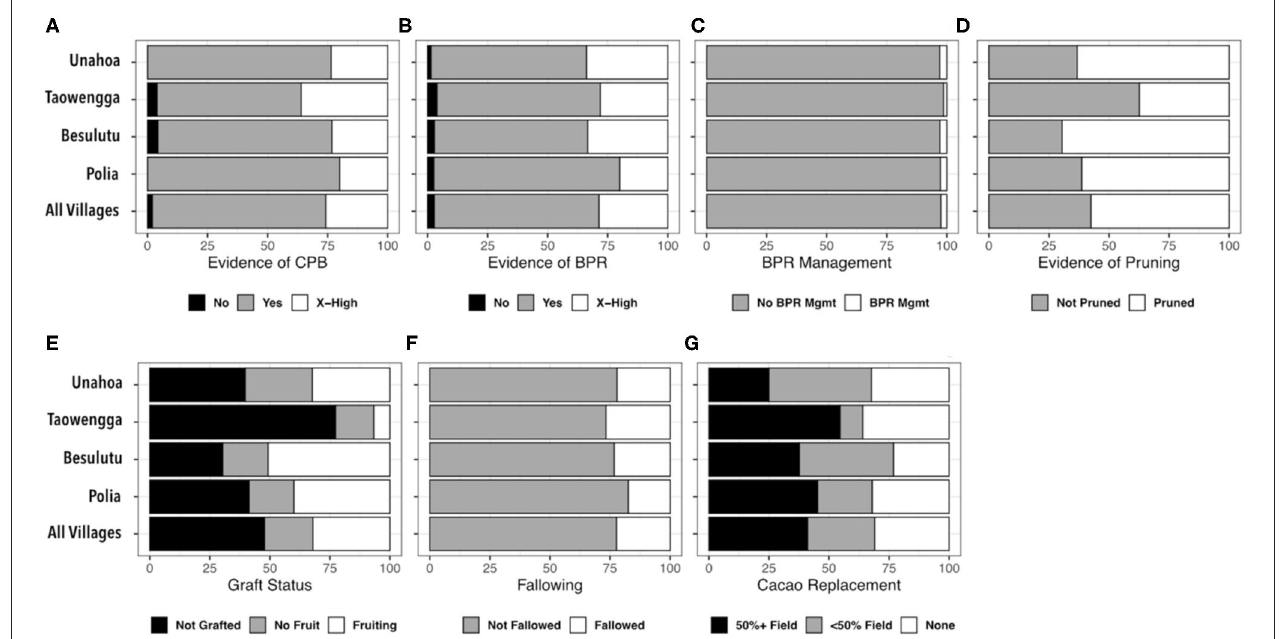
FIGURE 2 | Land Management Transitions Captured by Land Use Surveys ( N = 289). This figure depicts observed land use transitions (2015) among a random sample of 289 cacao fields, as captured by the land use survey. Data are presented as percentages of all fields surveyed and testify to (A,B) evidence of pest and pathogen prevalence, where X-high indicates prevalence in > 50% of observable pods; (C) evidence of crop sanitation practices; (D) evidence of pruning; (E) the status of cacao trees with respect to vegetative grafts, and with respect to the fruiting status of grafts; (F) evidence of field fallowing, indicated by high weed cover and unharvested pods; and (G) the full or partial replacement of cacao trees within fields with other commodity